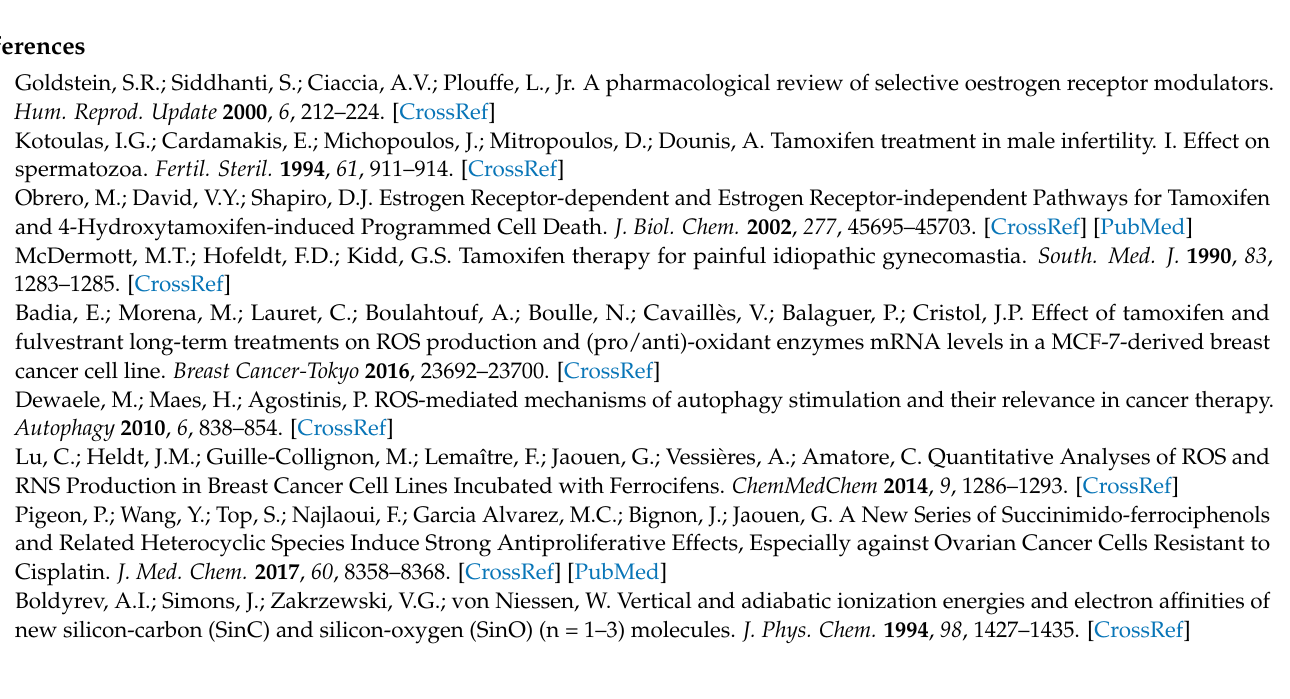
SSCE: Figure S1; Cyclic voltammograms recorded at Pt (surface area A = 8.1 mm 2 ) in contact with (A) 0.1 M Bu 4 NClO 4 + 1 mM 18 in MeCN; (B) 0.1 M Bu 4 NClO 4 + 1 mM 38 in MeCN; (C) 0.1 M Bu 4 NClO 4 + 0.5 mM ferrocene in MeCN. Scan rate: (A,B) v = 1 V/s; (C) v = 0.05 V/s: Figure S2; Cyclic voltammograms recorded at Pt (surface area A = 8.1 mm 2 ) in contact with 0.1 M Bu 4 NClO 4 + 1 mM 1 ; 23 ; 24 ; or 25 in MeCN. Scan rate: v = 1 V/s: Figure S3 Cyclic voltammograms recorded at Pt (surface area A = 8.1 mm 2 ) in contact with 0.1 M Bu 4 NClO 4 + 1 mM 26 ; 28 ; 31 ; or 31a in MeCN. Scan rate: v = 1 V/s Figure S4. Cyclic voltammograms recorded at Pt (surface area A = 8.1 mm 2 ) in contact with 0.1 M Bu 4 NClO 4 + 1 mM 32 ; 33 ; 44 ; or 46 in MeCN. Scan rate: v = 1 V/s: Figure